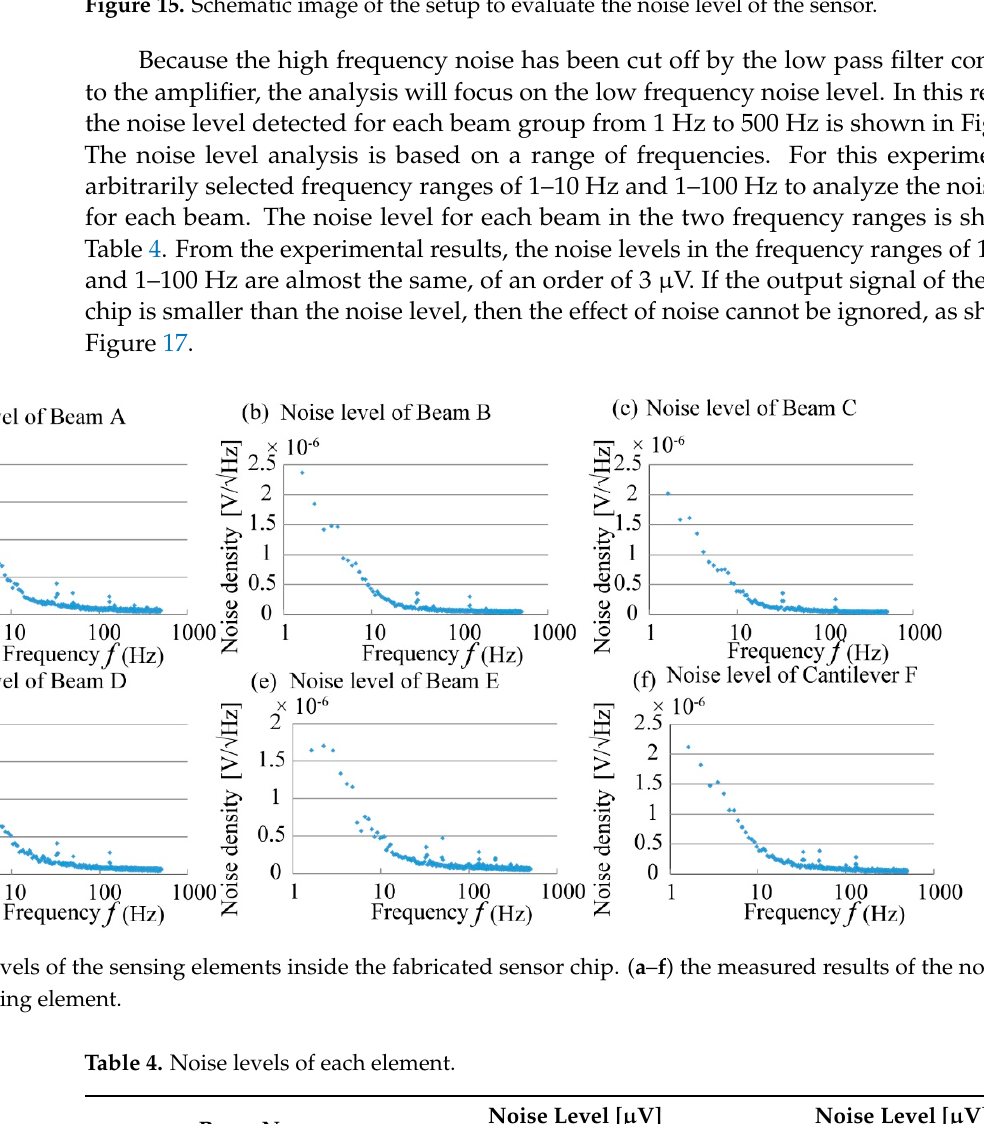
Figure 17. Relationship between the output signal and noise.